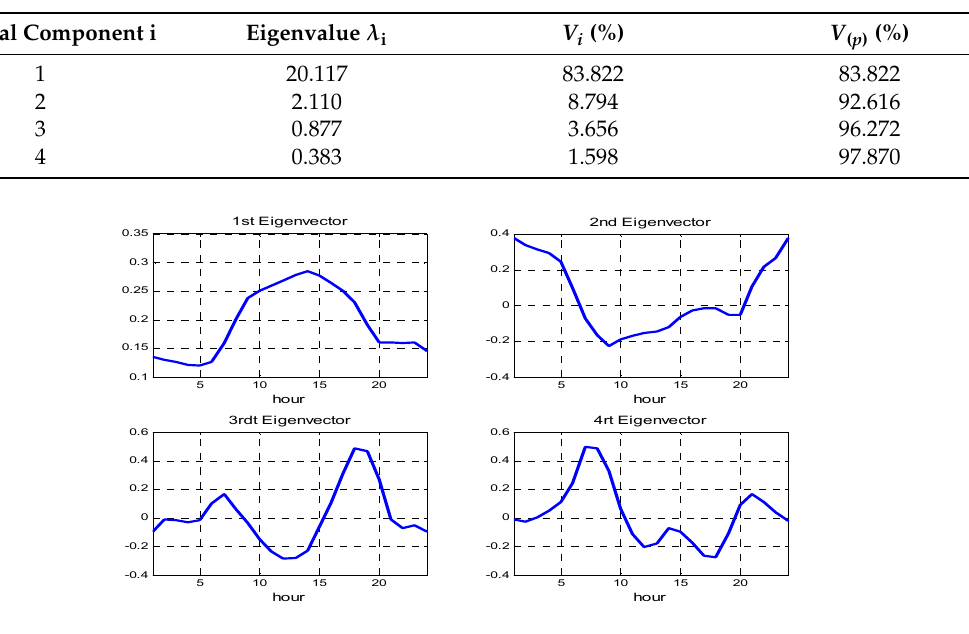
Figure 10. First four eigenvectors.